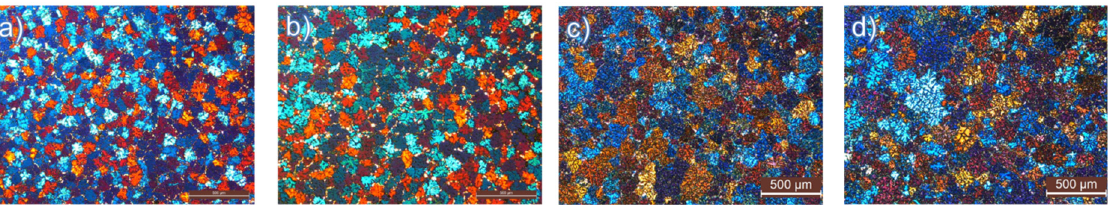
Figure 4. Influence of superheating and holding on the grain size for ( a ) HP AZ91 (AGS: 70 μ m), ( b ) HP AZ91 SH (AGS: 89 μ m), ( c ) HP AZ91 SH-1h (AGS: 69 μ m), and ( d ) HP AZ91 SH-2h (AGS: 70 μ m).